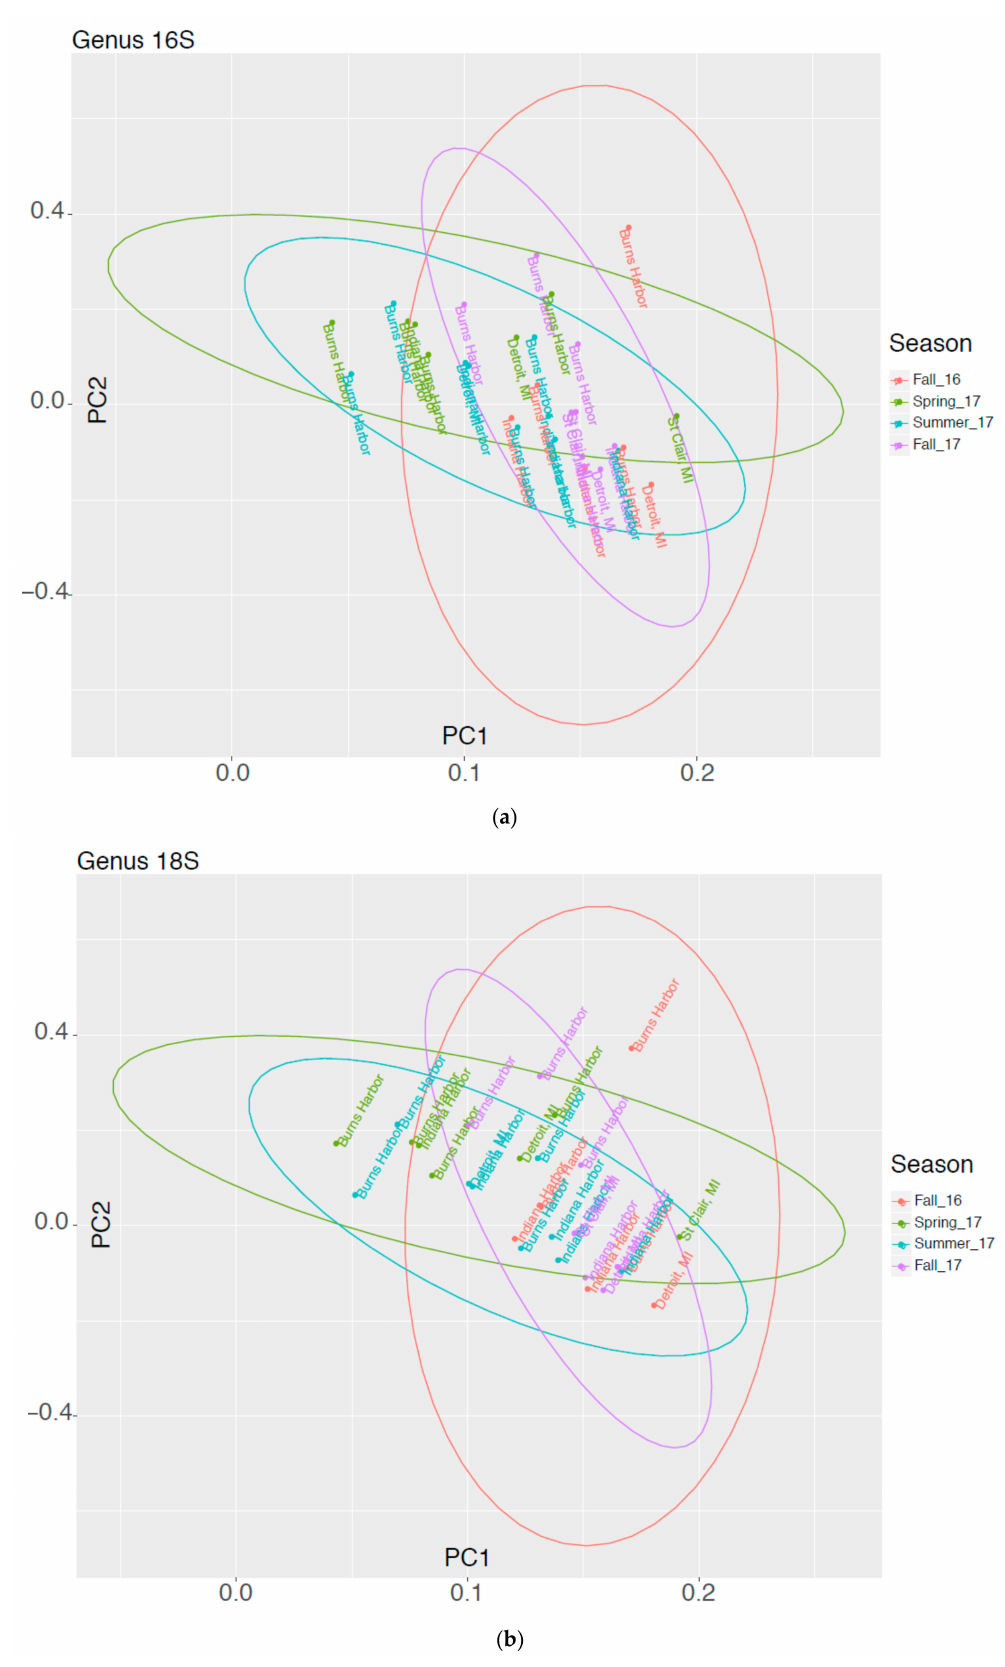
Figure 2. Graphical Representation of Molecular Data as a Function of Harbor and Season for ( a ) 16S and ( b ) 18S